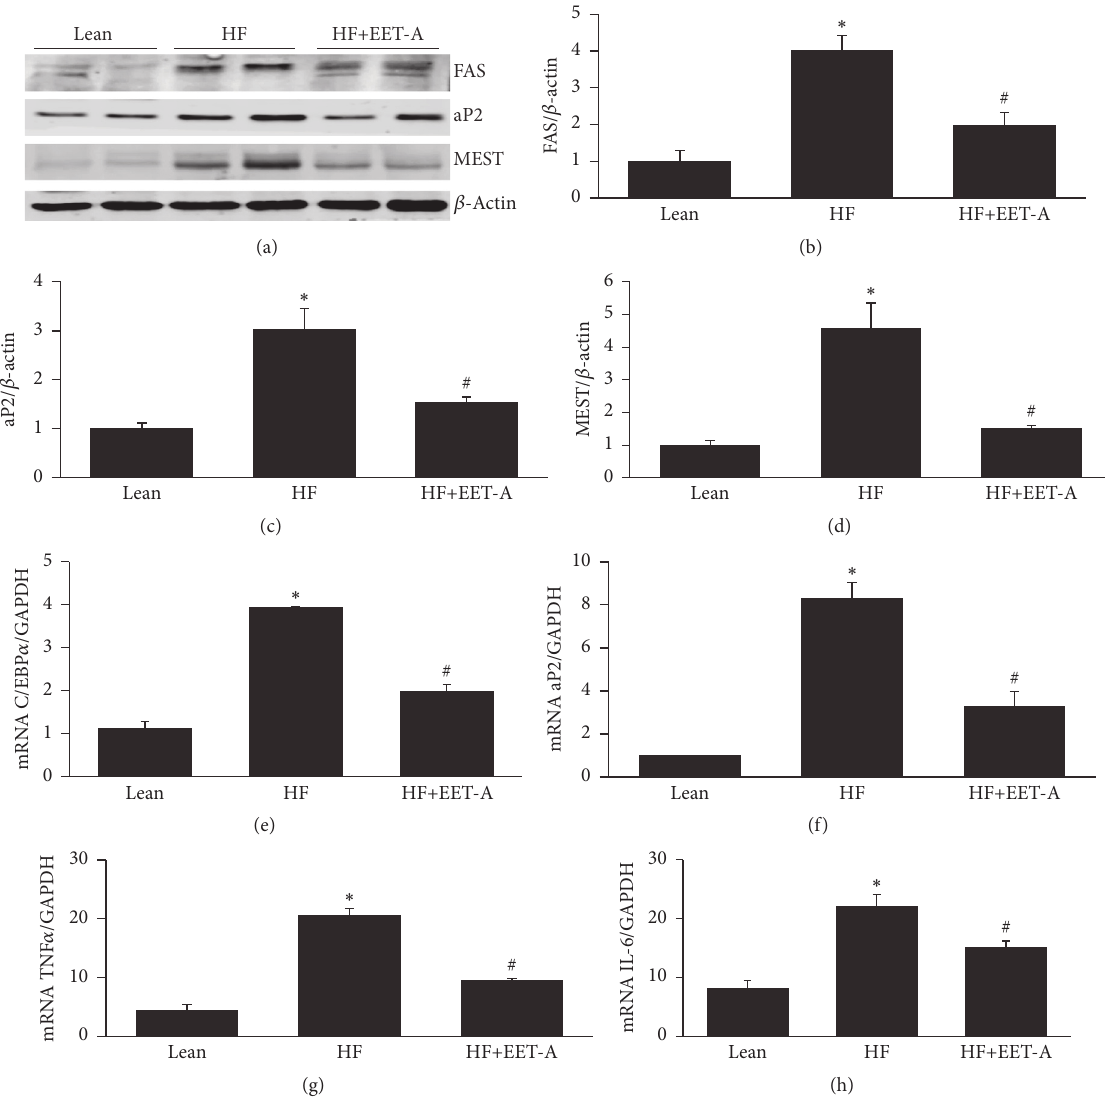
Figure 7: Effect of high fat diet and long-term treatment with EET-A on protein and mRNA expression of adipogenic markers and inflammatory cytokines. (a) Representative Western blots of FAS, aP2, and MEST proteins. Densitometric analyses of (b) FAS and (c) MEST proteins. (d) Protein and (e) mRNA levels of aP2. (f) C/EBP 𝛼 , (g) TNF- 𝛼 , and (h) IL-6 mRNA levels. Data are normalized to 𝛽 -actin for protein or GAPDH for mRNA. Results are mean ± SE, 𝑛 = 4 , ∗ 𝑝 < 0.05 versus lean, and # 𝑝 < 0.05 versus